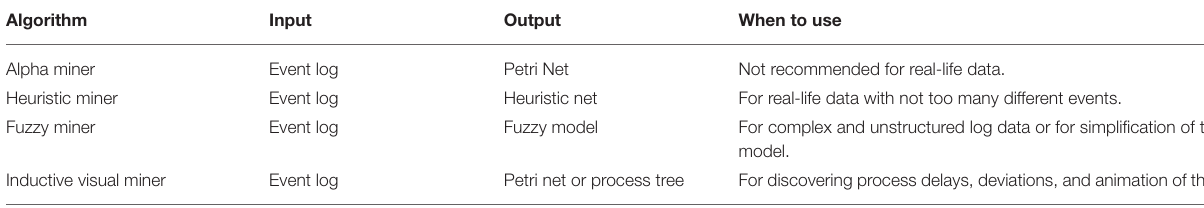
TABLE 1 | Comparison of mining algorithms.